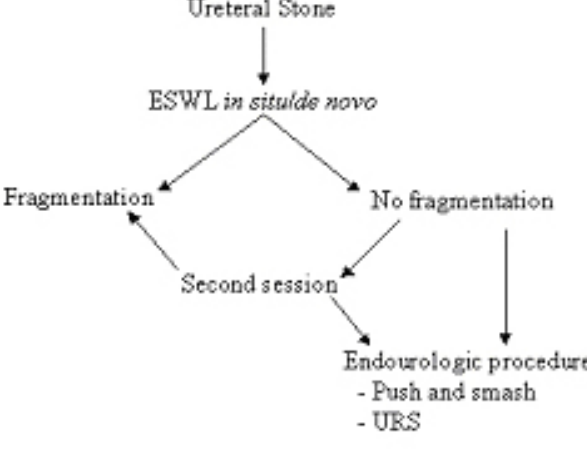
Fig. 1. Activated microglia identified by RCA-1 stain. Scale bar = 100